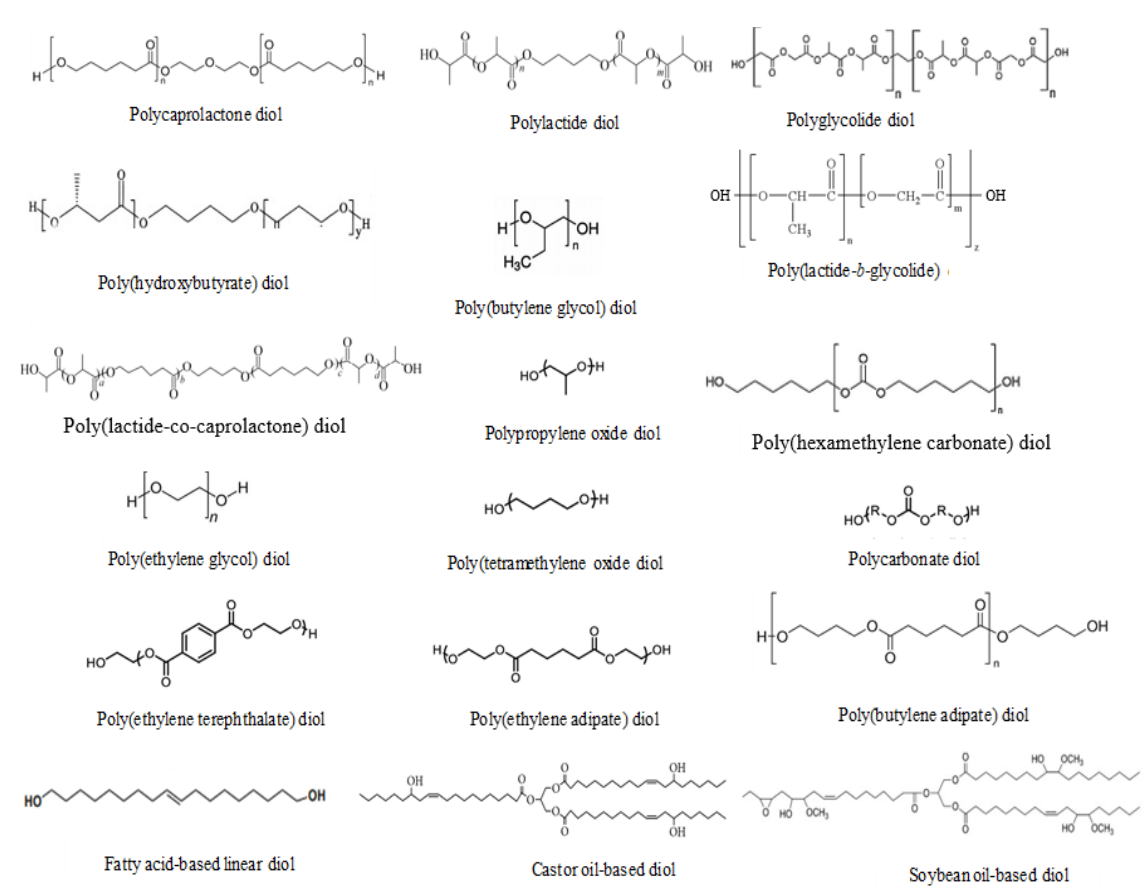
Figure 2. List of diols materials commonly used in polyurethane synthesis.